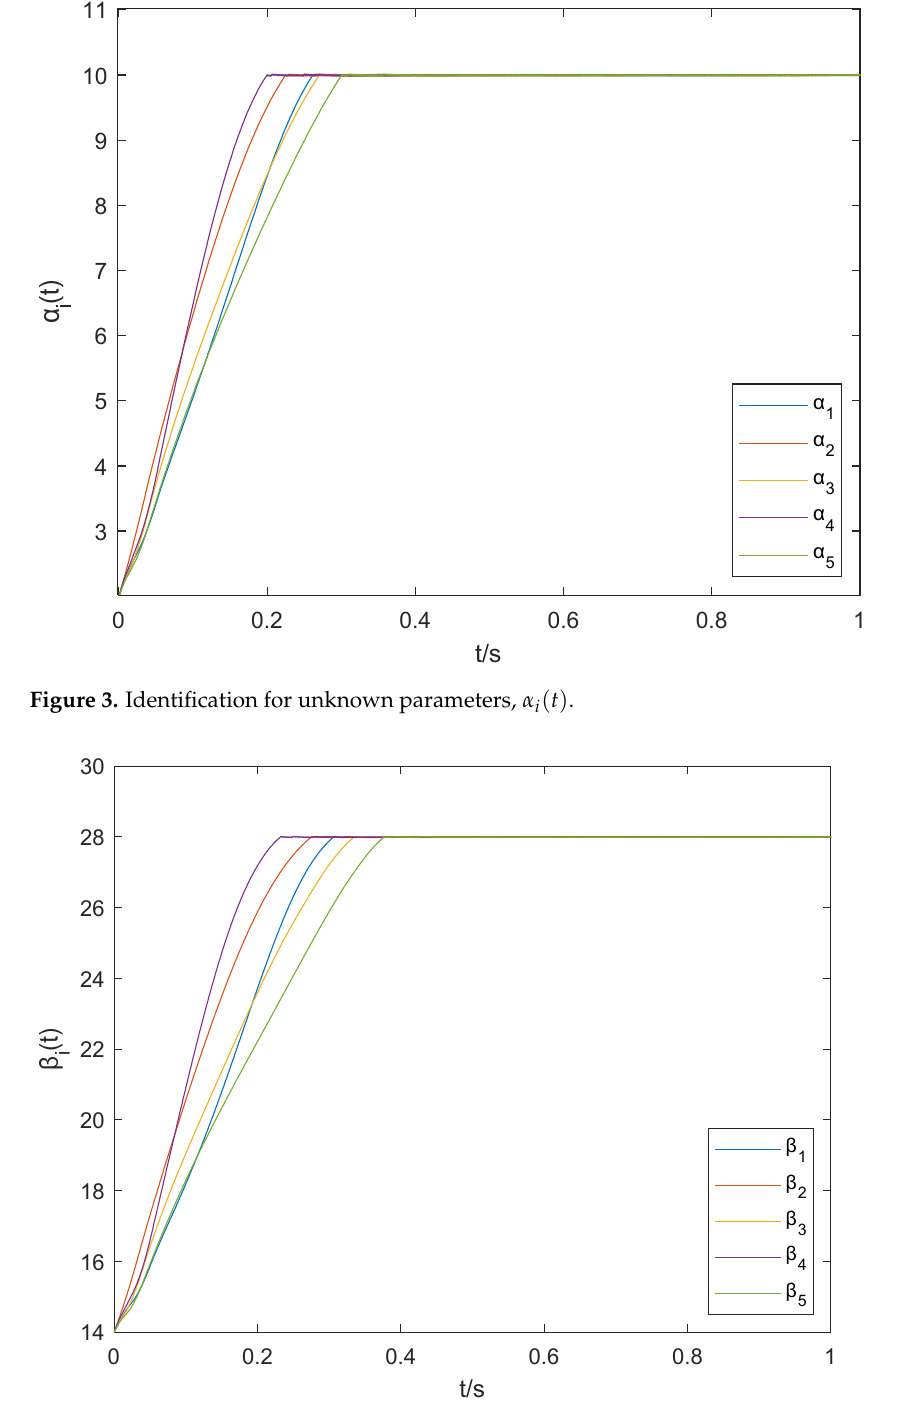
Figure 4. Identification for unknown parameters, β i ( t )